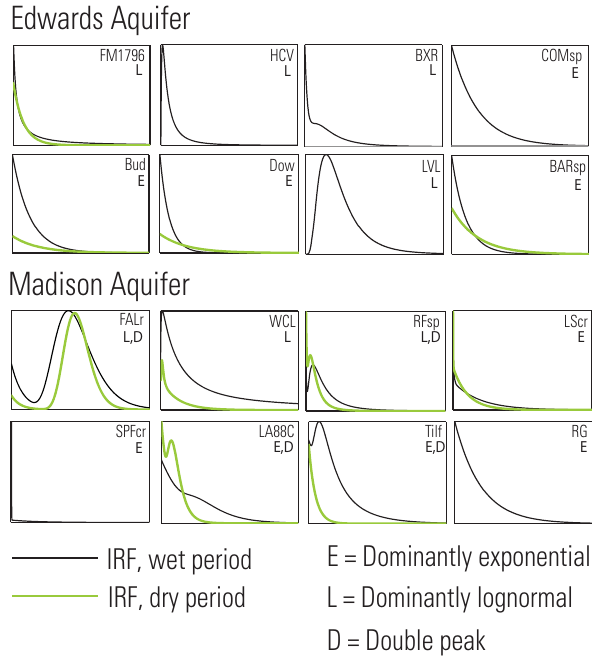
Fig. 6. Impulse-response functions (IRFs) plotted for scale- independent comparison. The vertical axes extend from zero to